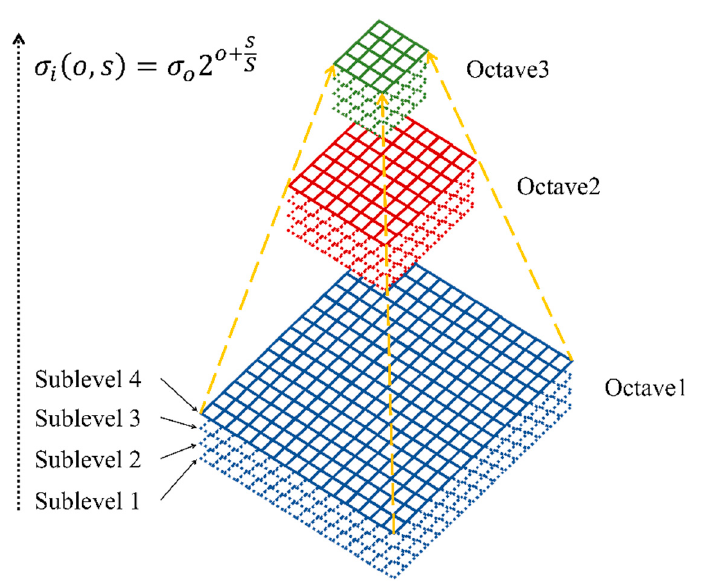
Figure 2. Creation of the nonlinear di ff usion scale (NDS)